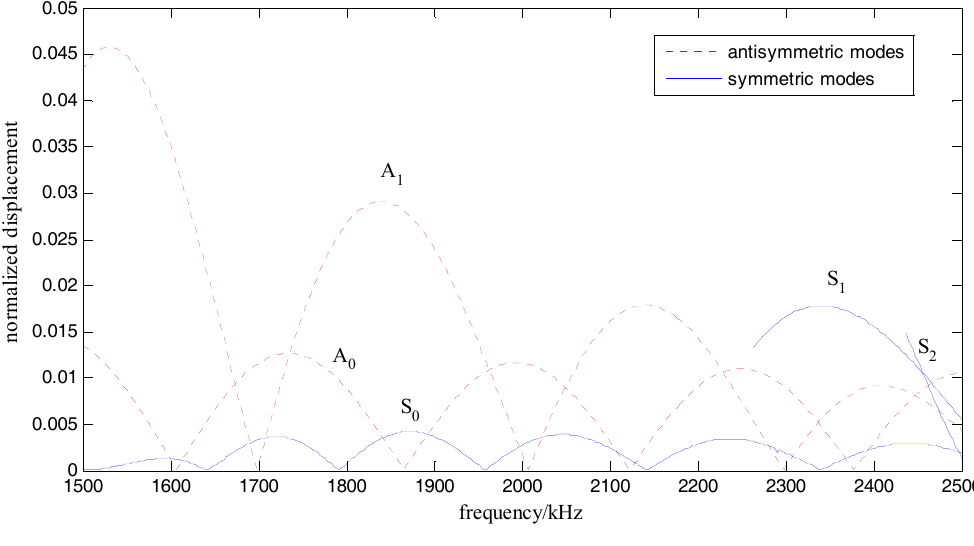
Figure 14. Normalized displacement of different modes of Lamb waves. Table 6. Normalized displacements of different modes of Lamb waves.